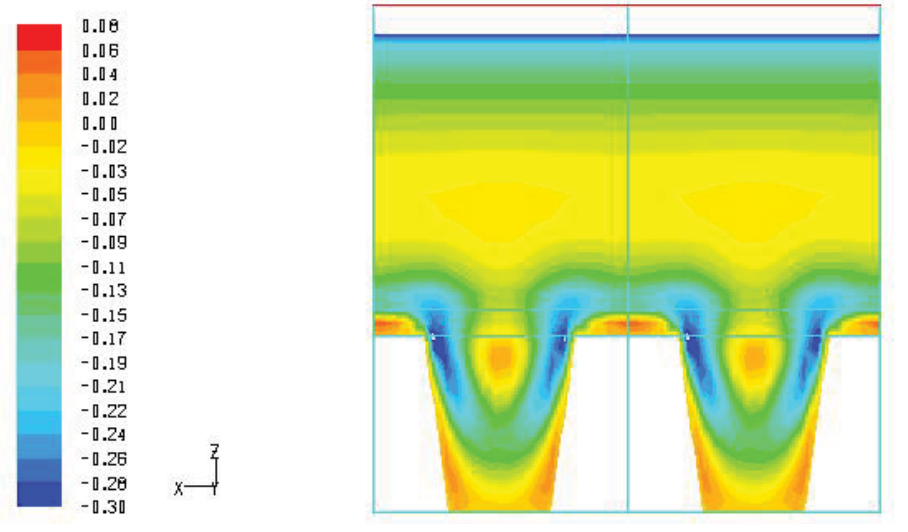
Figure 9: Radial velocity component (z) – cross section through the protrusions (row 1) The possible mixing movements in the flow field are shown for instance in the serial of Fig. 9 to Fig. 11 with radial velocity in several cross sections in the planes x-z (across to the direction of the rotation). Without any next analysis, it is visible the air movement in this direction – the details depend on the actual position (y) of the plane of observation